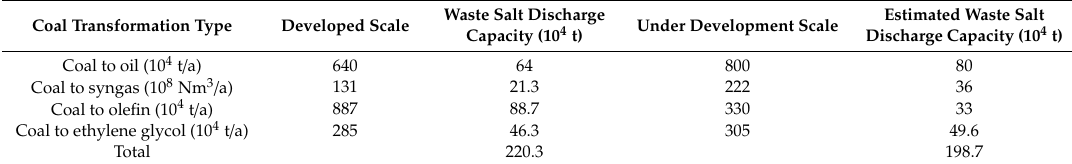
Table 1. Estimation of waste salt discharge capacity from the coal chemical industry in China a